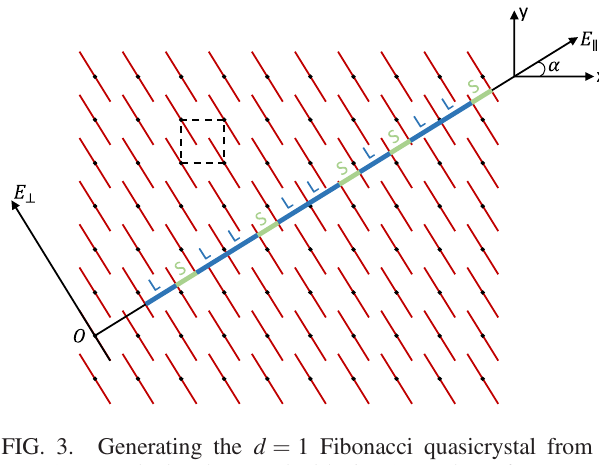
FIG. 3. Generating the d ¼ 1 Fibonacci quasicrystal from a D ¼ 2 square lattice decorated with d ¼ 1 atomic surfaces σ (red line segments). Black dots denote lattice sites, and dashed black lines indicate the superspace unit cell. Intersections between the atomic surfaces and physical space E generate the quasicrystal; k the intersections divide E into a sequence of long ( L , in blue) k and short ( S , in green)